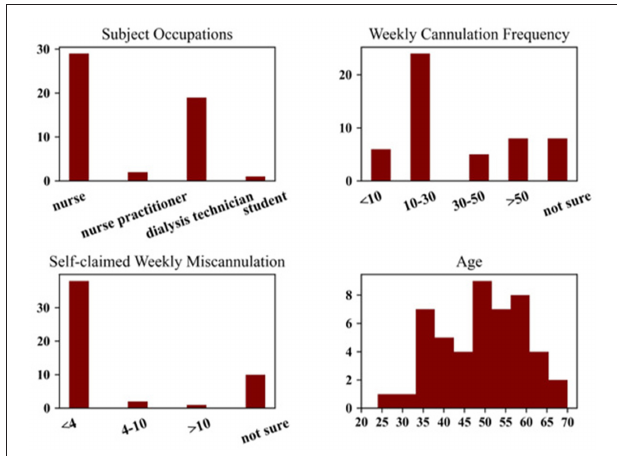
FIGURE 3 | Demographic information of the study population.